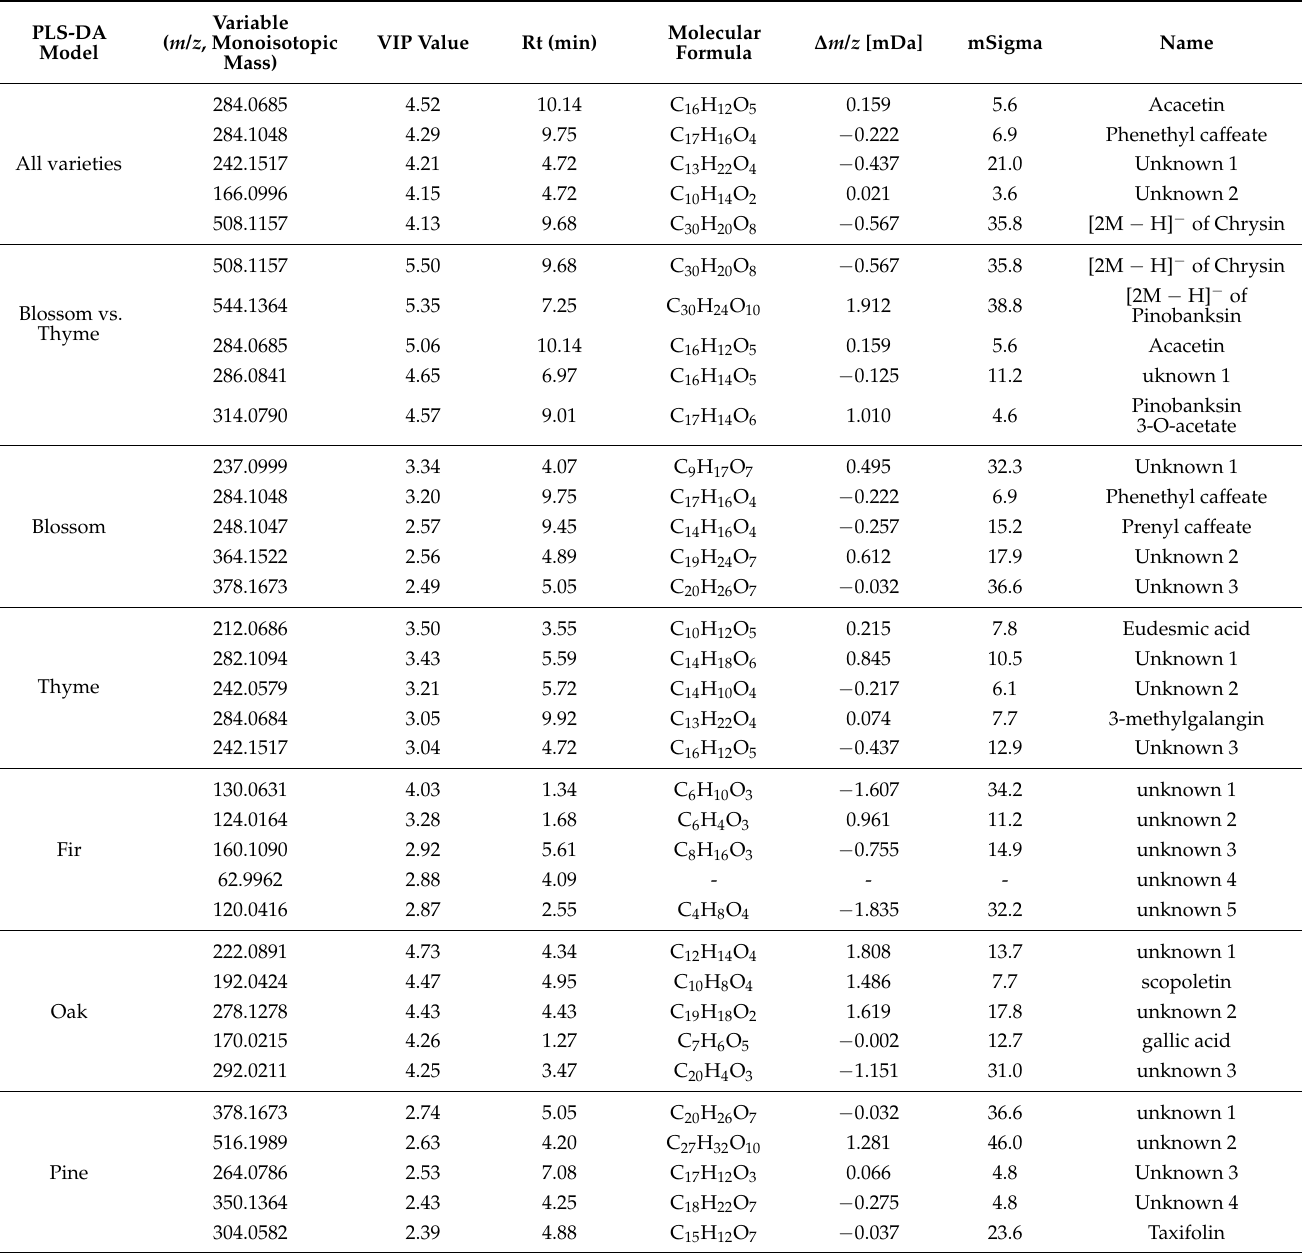
Table 3. Identification of Important markers proposed by PLS-DA